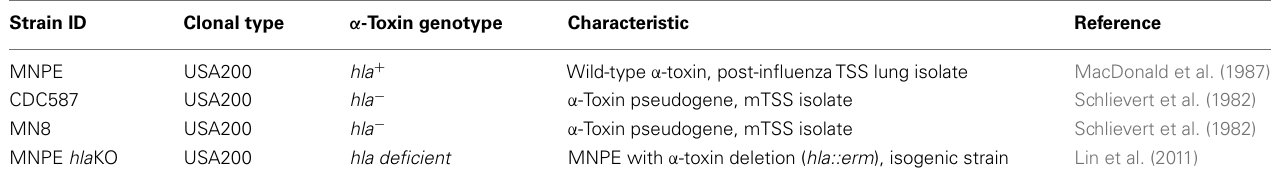
Table 1 | Staphylococcus aureus strains used in this